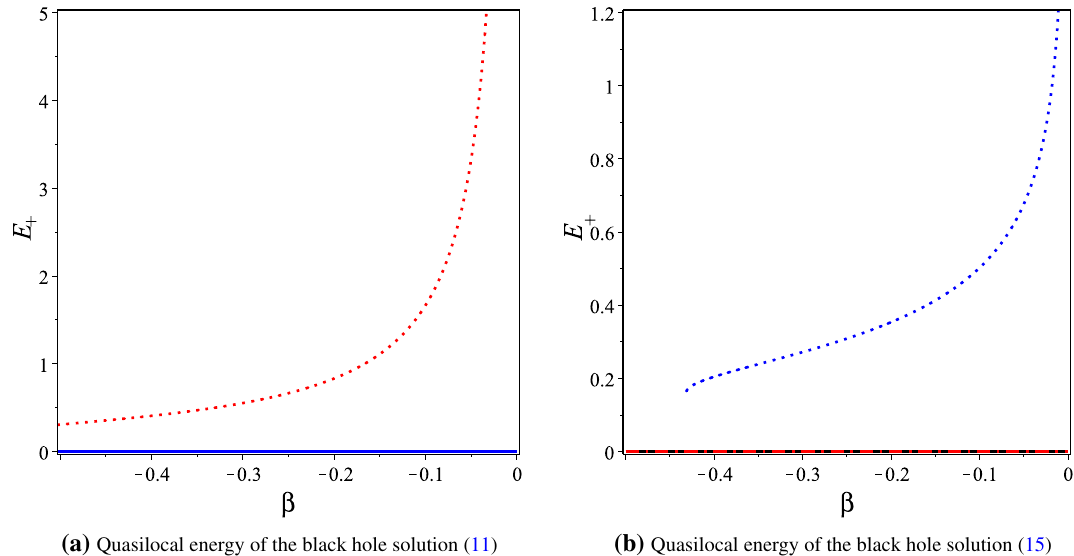
( a ) Quasilocal energy of the black hole solution (11) (b) Quasilocal energy of the black hole solution (15) Fig. 6 Schematic plot of the quasilocal energy of the two black holes (11) and (15) versus the dimensional parameter α The constraint w( r ( ¯ r + )) = 0 for the flat and AdS/Ad cases